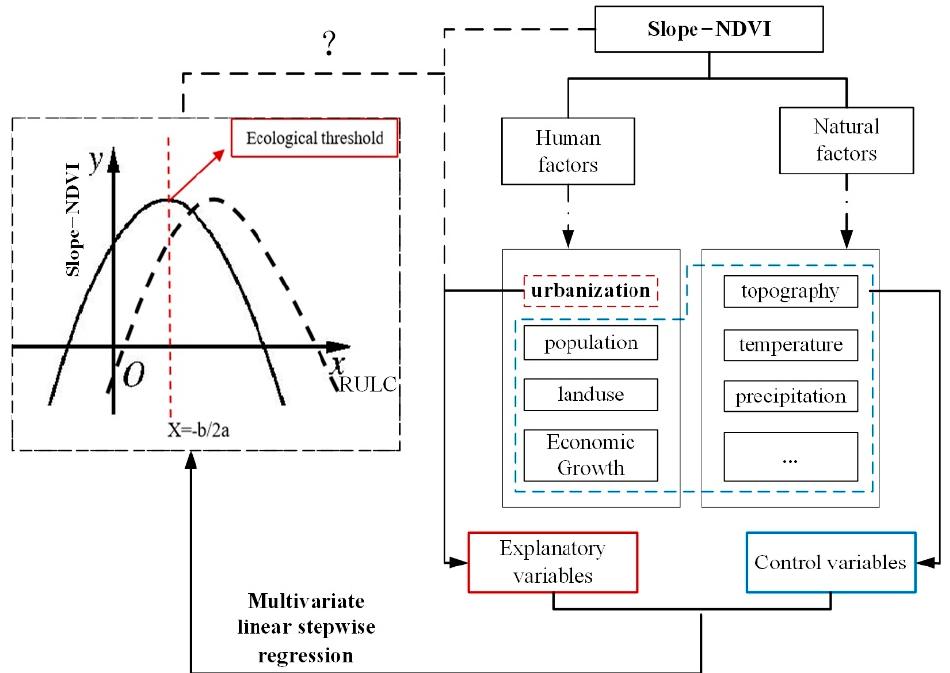
Figure 1. Flowchart of the algorithm used to estimate the effects of urbanization on vegetation dy- namics.